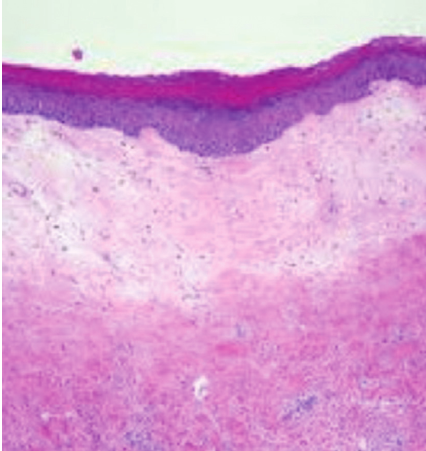
Figure 4: Thin epithelium with loss of rete edges, hyperkeratosis, fibrin deposition, and loss of vascularity and chronic inflammatory cell infiltrate of lymphocytes in deeper layer on